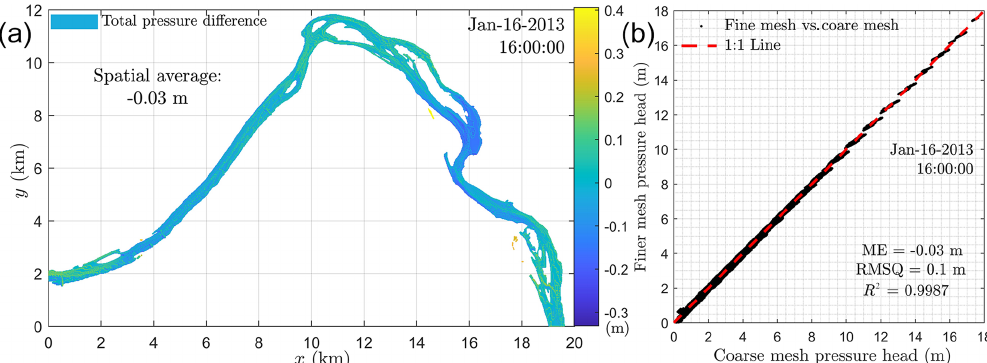
Figure A1. Distribution of the difference between total pressure modeled with a fine mesh and a coarse mesh (a) , and the 1 : 1 plot of the total pressure from the fine mesh and the coarse mesh (b)